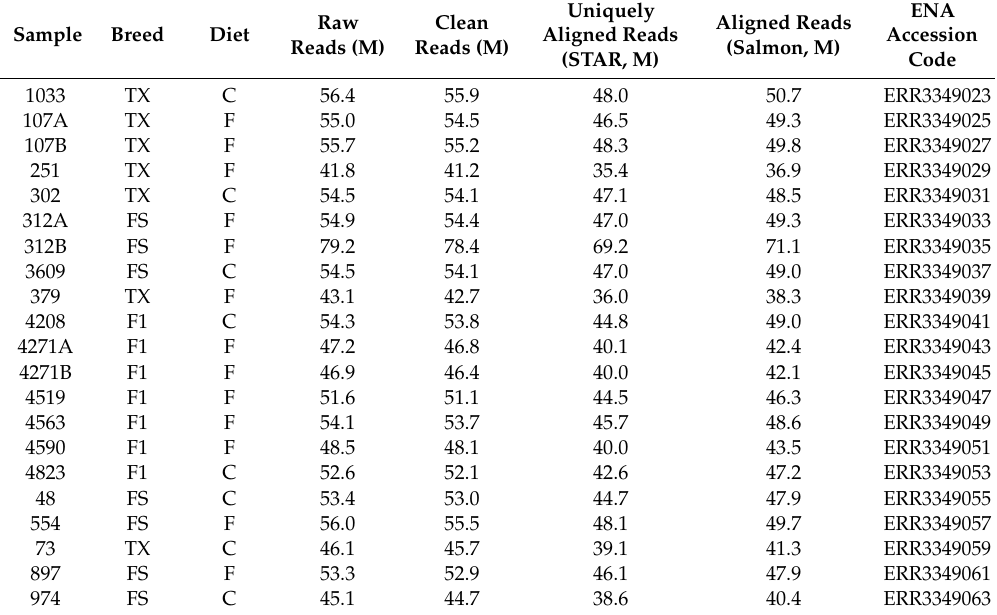
Table 2. Sample summary. A total of 21 samples with 7 each for Finnsheep (FS), Texel (TX) and F1 crosses of Finnsheep and Texel (F1) were included in this study. Diet is either normal diet (C) or flushing diet (F). Alignment statistics from STAR include only the uniquely aligned reads whereas those from Salmon include all reads that mapped to reference transcriptome. Numbers for sequence reads are represented as millions